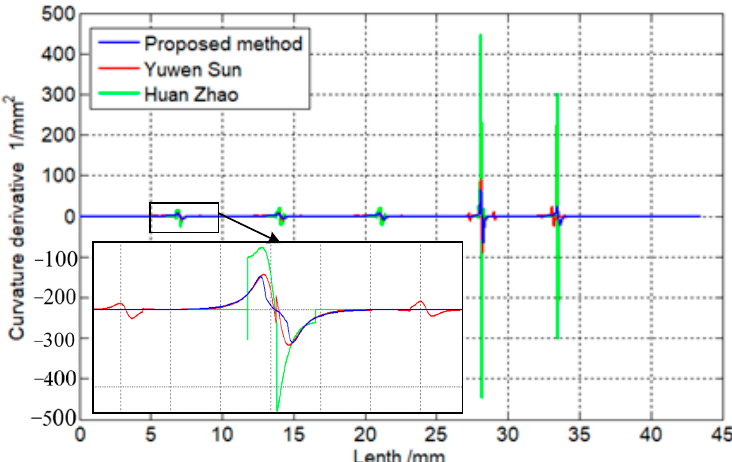
Figure 8. Curvature profiles of 3D tool path.